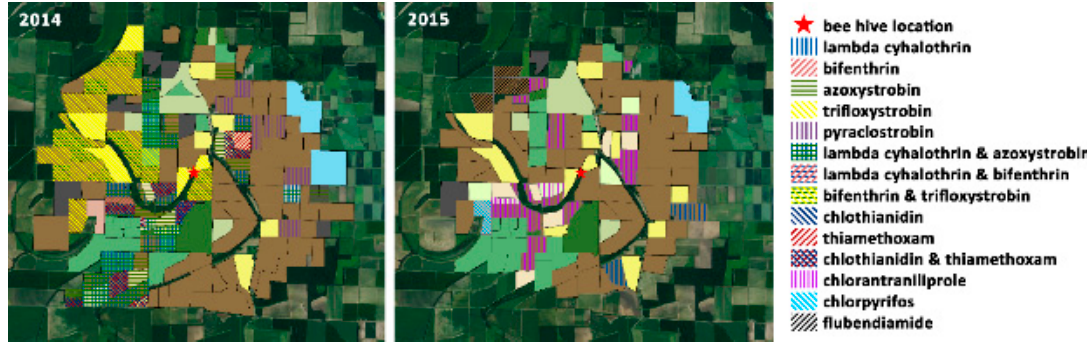
Figure 5. Reported distribution of neonicotinoid insecticides applied as seed treatments within the High-Ag survey area during the 2014 and 2015 growing seasons.